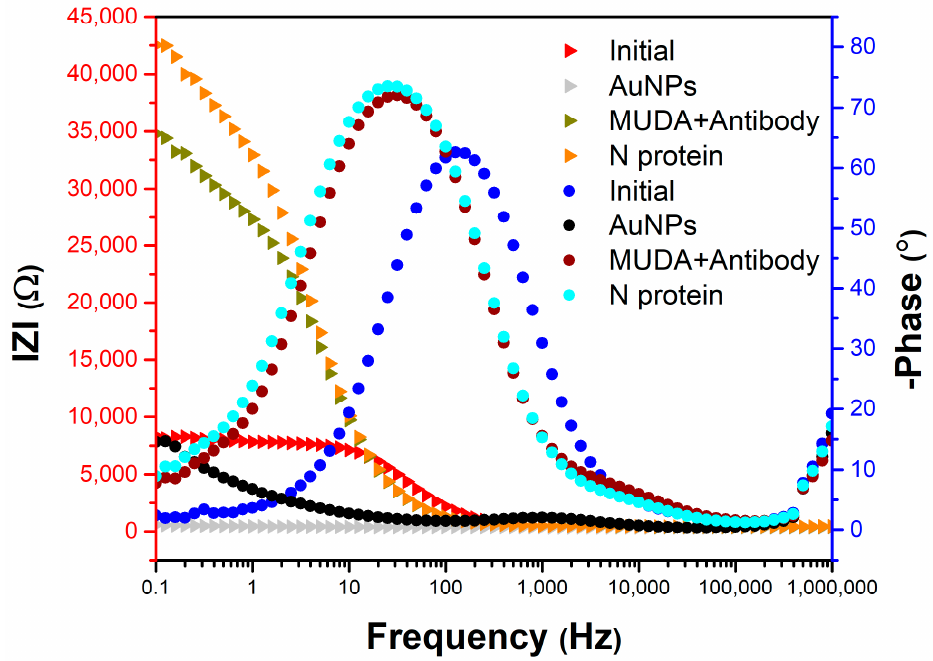
Figure 9. Bode diagram for the S7/02.08 sensor (WE area = 12.6 mm 2 ) with measurements after AuNP decoration, MUDA functionalization + antibody immobilization (one step), and N-protein binding.